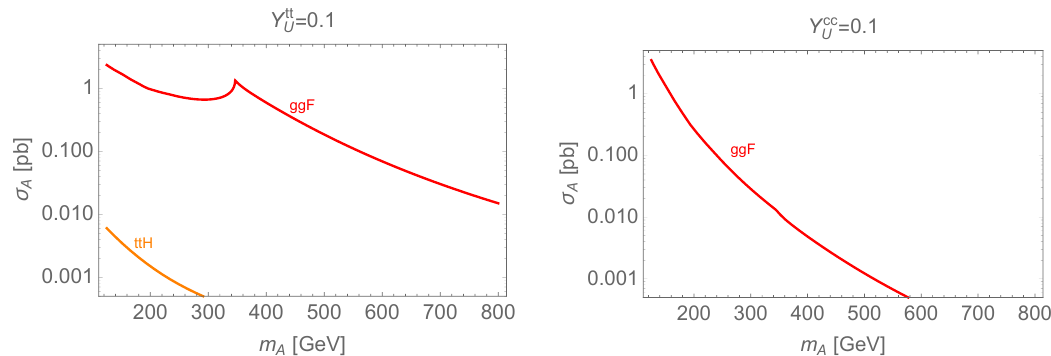
Figure 1. The production cross-section of the pseudoscalar A as a function of its mass. The gluon-fusion channel is shown in red and the t (cid:22) tA channel is shown in orange. On the left pane Y tt = 0 : 1 while on the right pane Y cc = 0 : 1. Other Yukawa couplings are taken to be 0. U U Notice that the (cid:13)avor violating Higgs Yukawa couplings are encoded in the Yukawa matrices Y ‘ , Y U and Y D